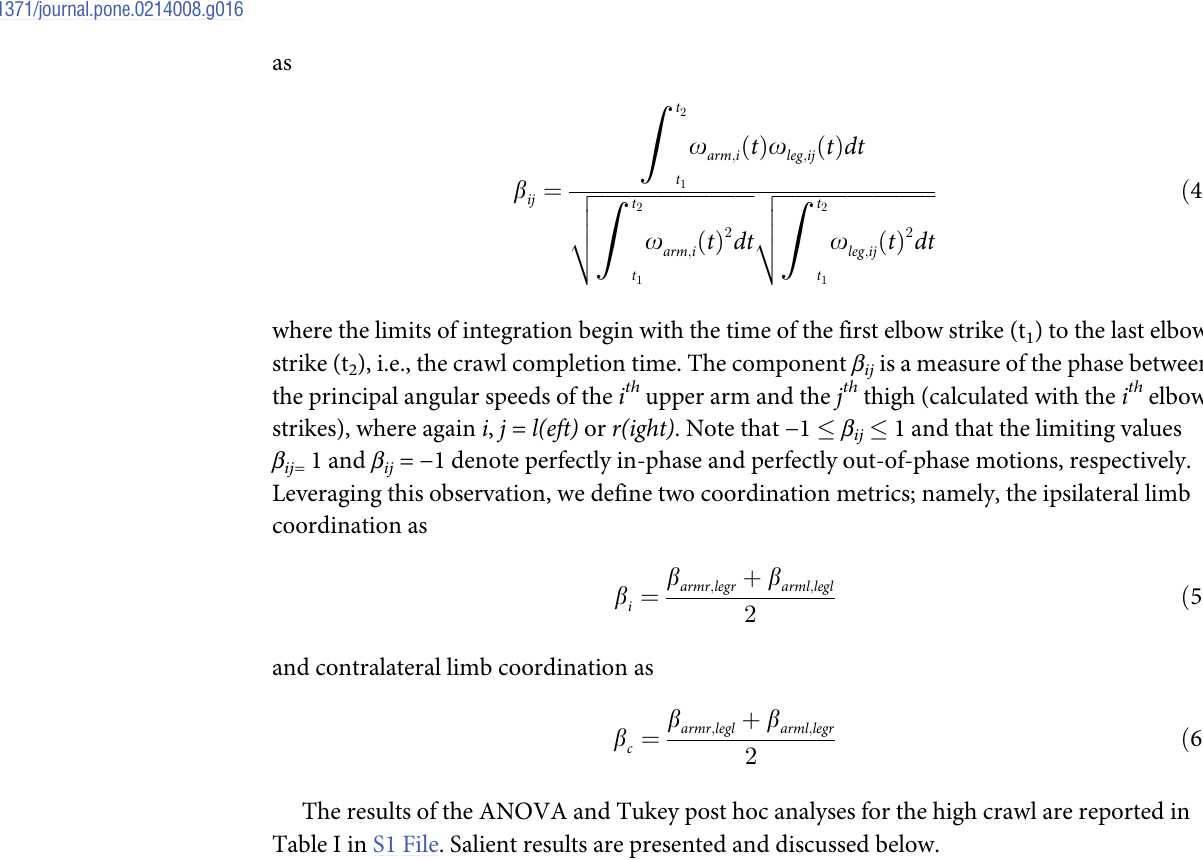
ffiffiffiffiffiffiffiffiffiffiffiffiffiffiffiffiffiffiffiffiffiffiffiffiffiffiffiffiffiffiffi Z